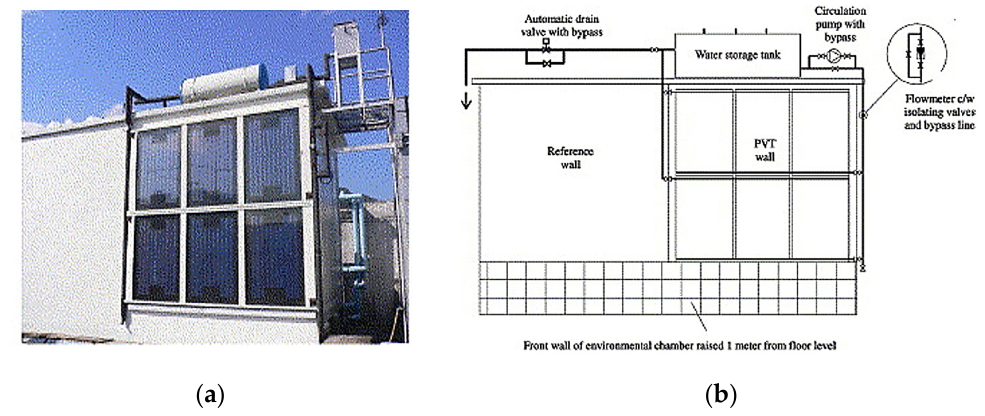
Figure 10. Experimental set-up of BIPVT ( a ) real photo ( b ) schematic diagram. Reproduced with permission from ref. [166]. Copyright 2007 Elsevier.